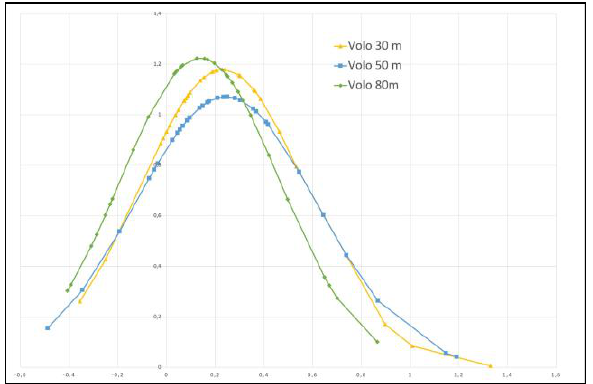
Figure 13. Normal distribution of